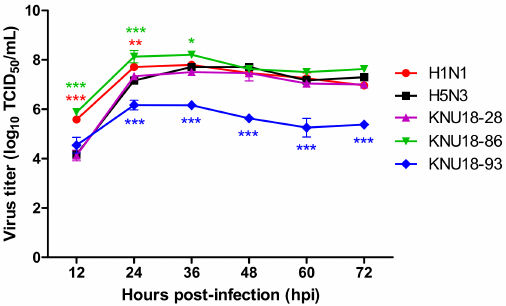
Figure 4. Growth kinetics replication of three novel H5N2 isolates in MDCK cells. Five kinds of viruses were infected with 0.01 multiplicity of infection (MOI) into MDCK monolayers. The virus supernatants were collected at different time points each 12 h until 71 h post-infection (hpi). The viral replication titers were then determined by the TCID 50 assay combined ELISA for detecting the nucleoprotein (NP) viral antigen. *, p < 0.05; **, p < 0.01; and ***, p < 0.001 showing comparison with H5N3